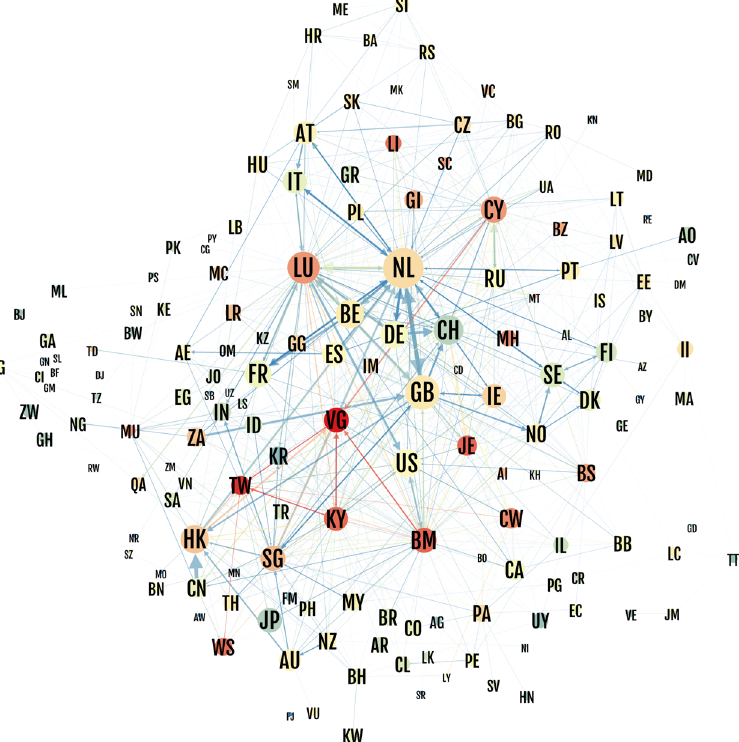
Figure 3. Network of ownership flows between countries. Node size is proportional to the unnormalized conduit-OFC (value flowing through the conduit towards sink-OFCs). Node color is sink centrality (value entering minus value leaving the country, divided by the GDP). Edge size is proportional to the value flowing through countries. Edge color is proportional to the significance of the flow in relation to a null model. See Supplementary Methods for an explanation of the null model.